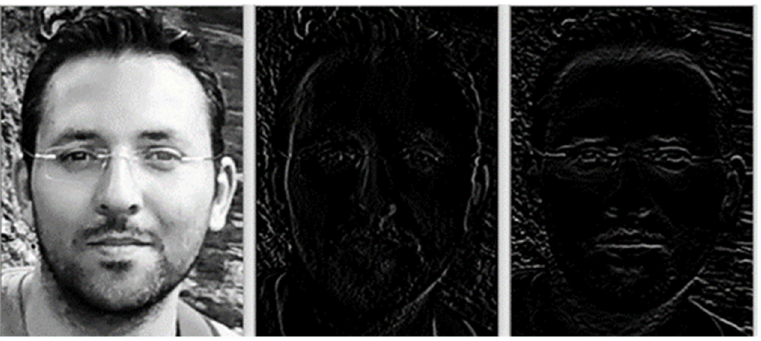
Figure 2. Original image ( left ), gradient image on x-axis ( center ), gradient image on y-axis ( right ). After obtaining the gradient magnitudes ( g ) and directions ( θ ) for each pixel, the image is divided into blocks in the second step and the histograms of the gradients for each block are calculated. There are 9 elements in the histogram, including 0°, 20°, 40°, 60°, 80°, 100°, 120°, 140°, and 160°.